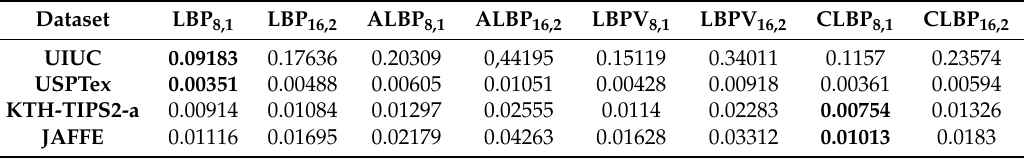
Table 7. Computational times, in seconds, for the extraction of LBP variants on the four datasets evaluated. LBP variants with underscored parameters neighborhood , radius